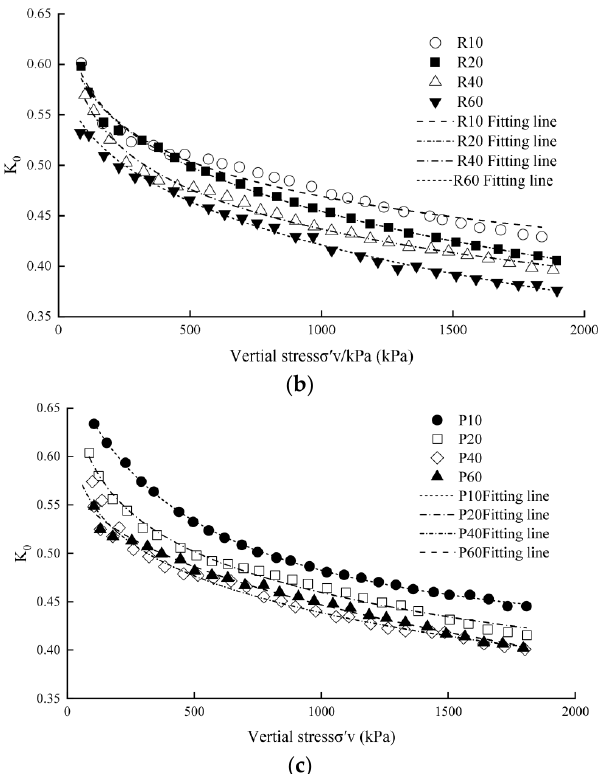
Figure 7. K 0 – σ v curves of the specimens for di ff erent techniques: ( a ) scalping technique, ( b ) replacement technique, and ( c ) parallel gradation technique.